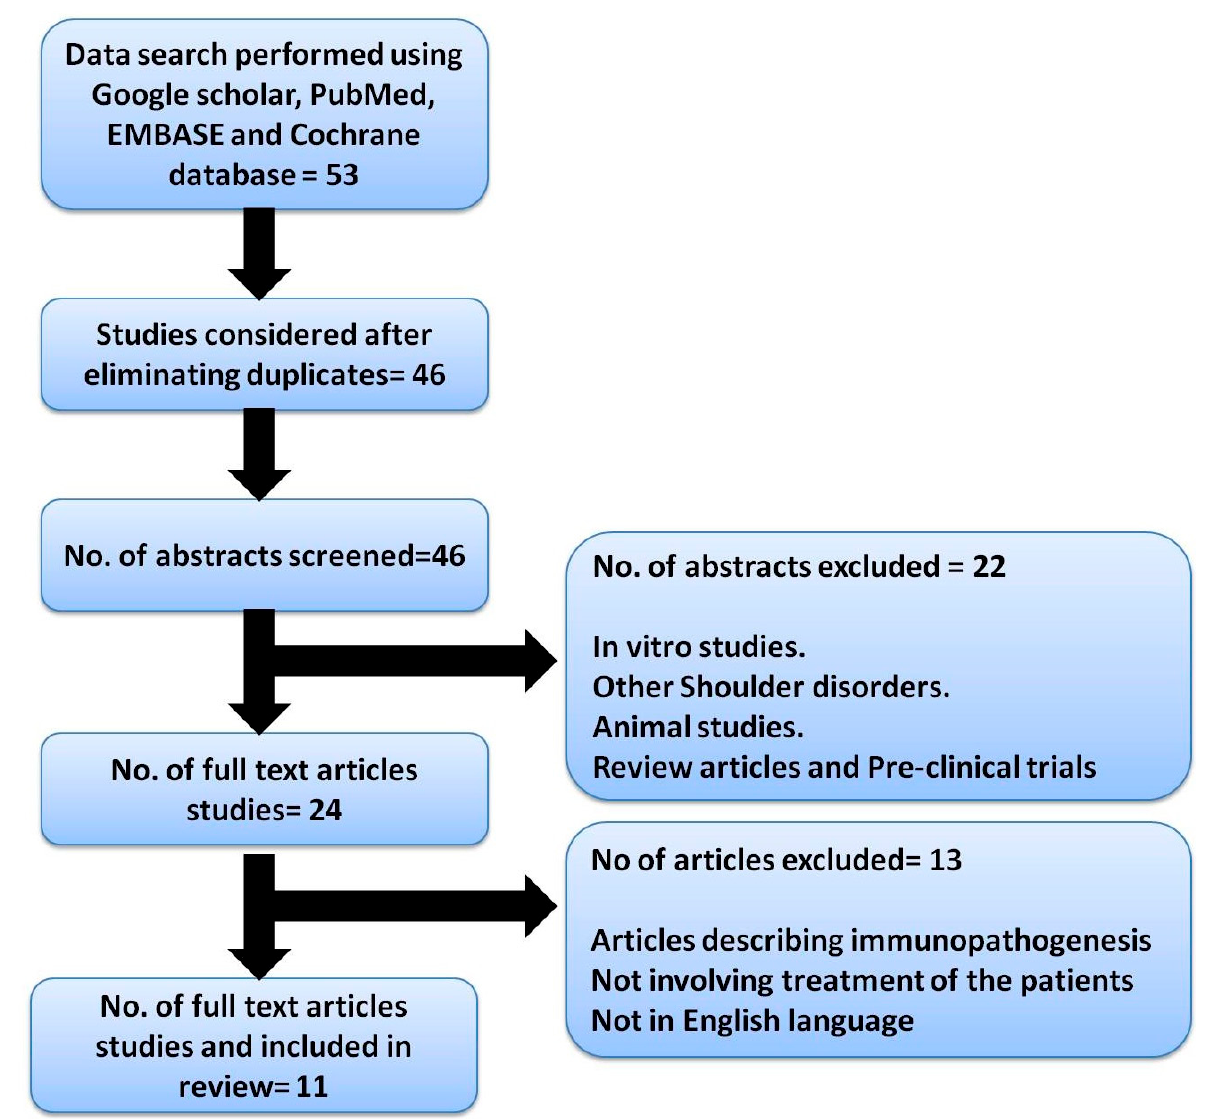
Figure 1. Describing the PRISMA chart.